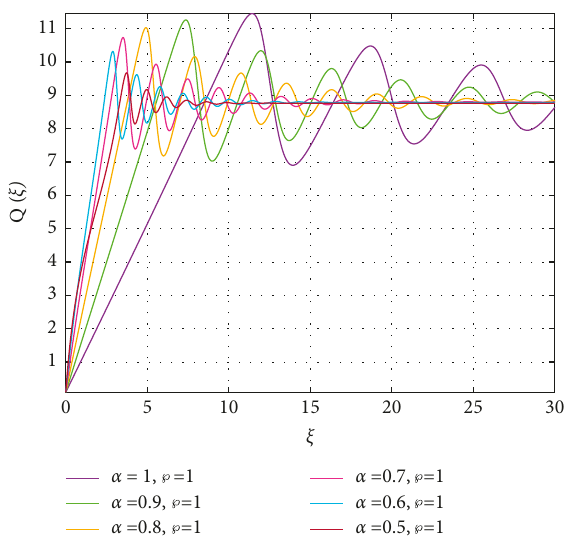
Figure 12: Displays of individuals who quit or not using Q ( ζ ) applying an another numerical approach for decreasing fractional- order α and fixed fractal-dimension ℘ �